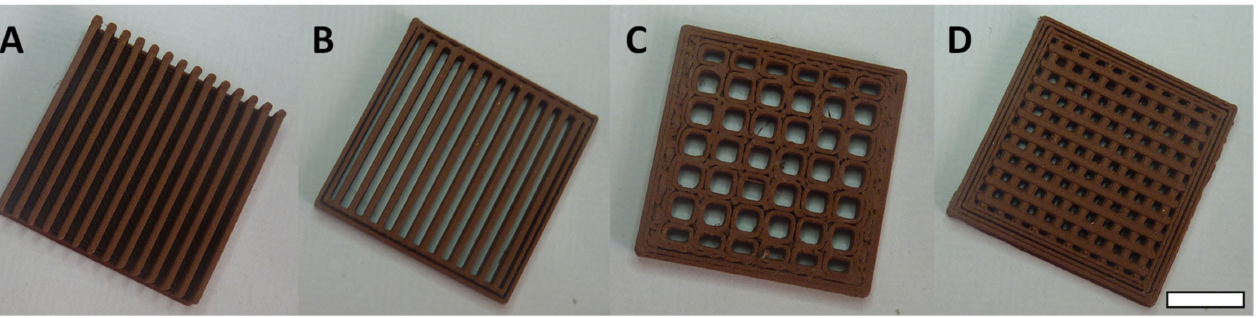
Figure 3. Examples of printed surfaces. ( A ) Plate with vertical blades (PVB), ( B ) Grid with vertical blades (GVB), ( C ) Large mesh grid (GLM) and ( D ) Narrow mesh grid (GNM) (Scale bar = 1